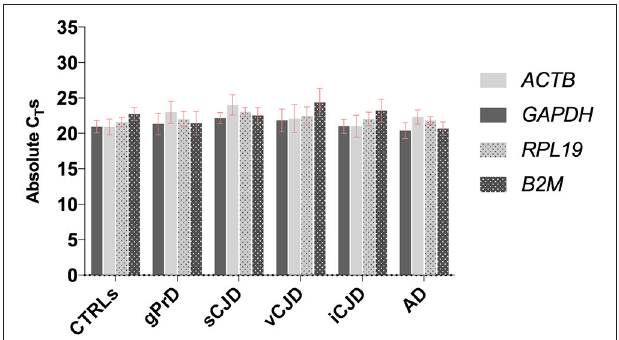
FIGURE 1 | Comparison between GAPDH , ACTB, RPL19, and B2M stability across controls and patients. For each group, average values of absolute C T s among the samples are shown. Each sample was analyzed in